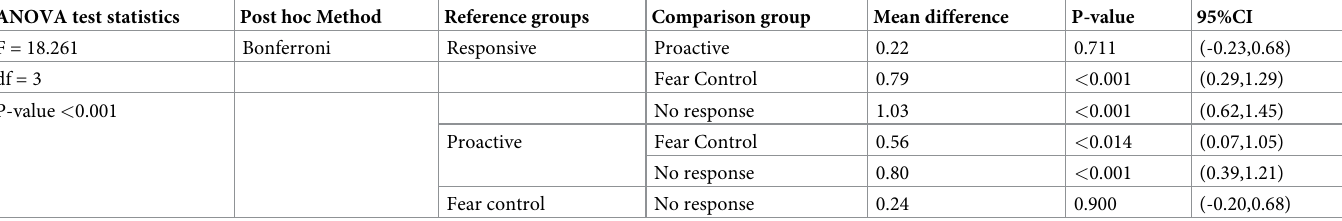
Table 6. Showing difference in mean diabetic self care practice by efficacy threat interaction (Quadrants) of patients with diabetes in JUMC, Ethiopia April 12-May 25 2020 (n = 343). ANOVA test